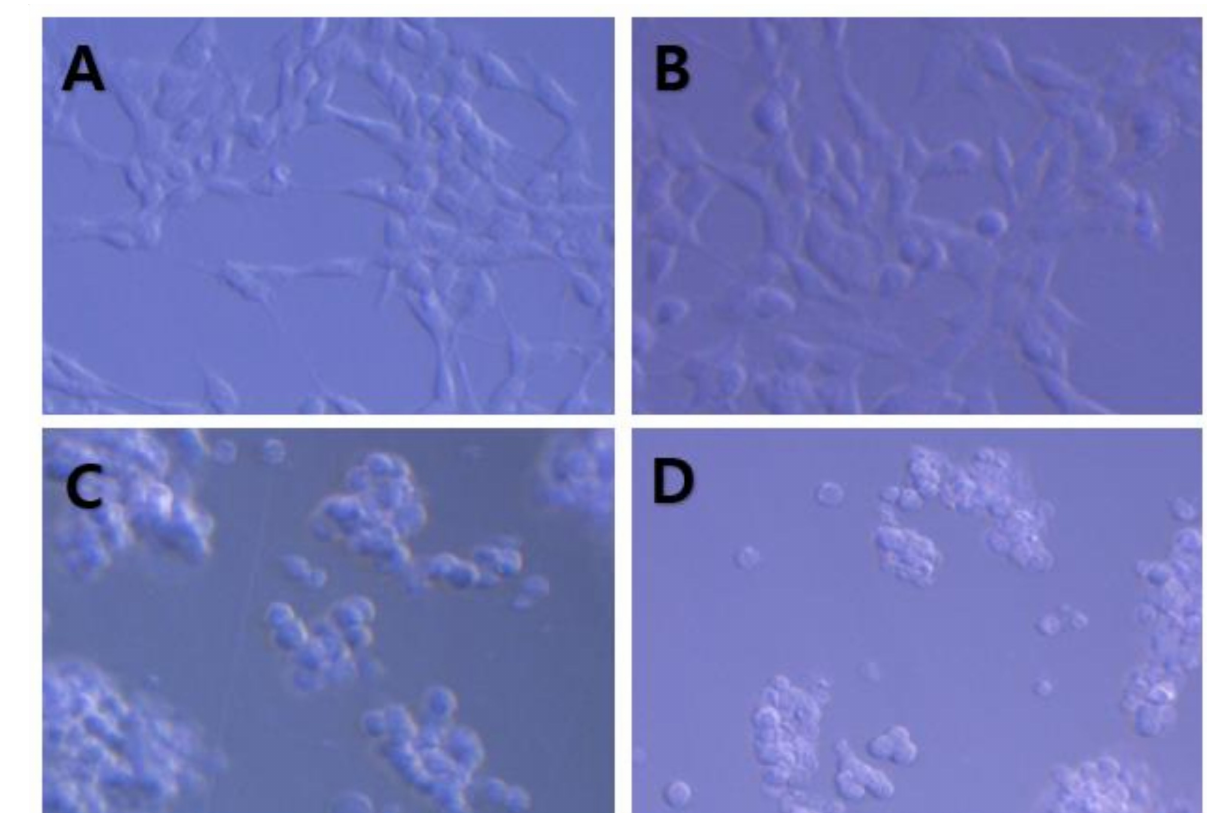
Figure 2. Representative morphological phase-contrast photomicrographs of vehicle- (control) ( A ) or TMT-exposed cells ( B – D ). TMT was administered as vehicle control ( A ), or at concentrations of 1 µ M ( B ), 10 µ M ( C ), or 30 µ M ( D ). No or weak neuronal injuries were observed at a TMT concentration of 1 µ M, whereas most neurons were massively damaged, with delayed swelling, neurite and cell body loss, and lysis at TMT concentrations of 10 and 30 µ